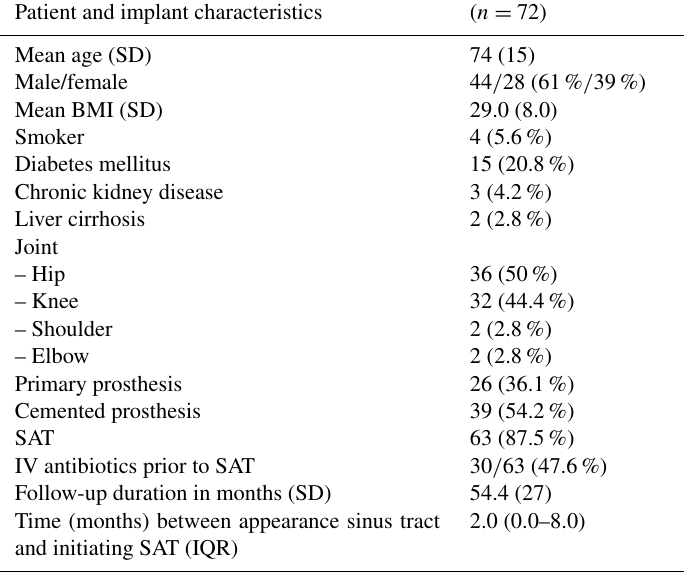
Table 1. Patient and implant characteristics. Patient and implant